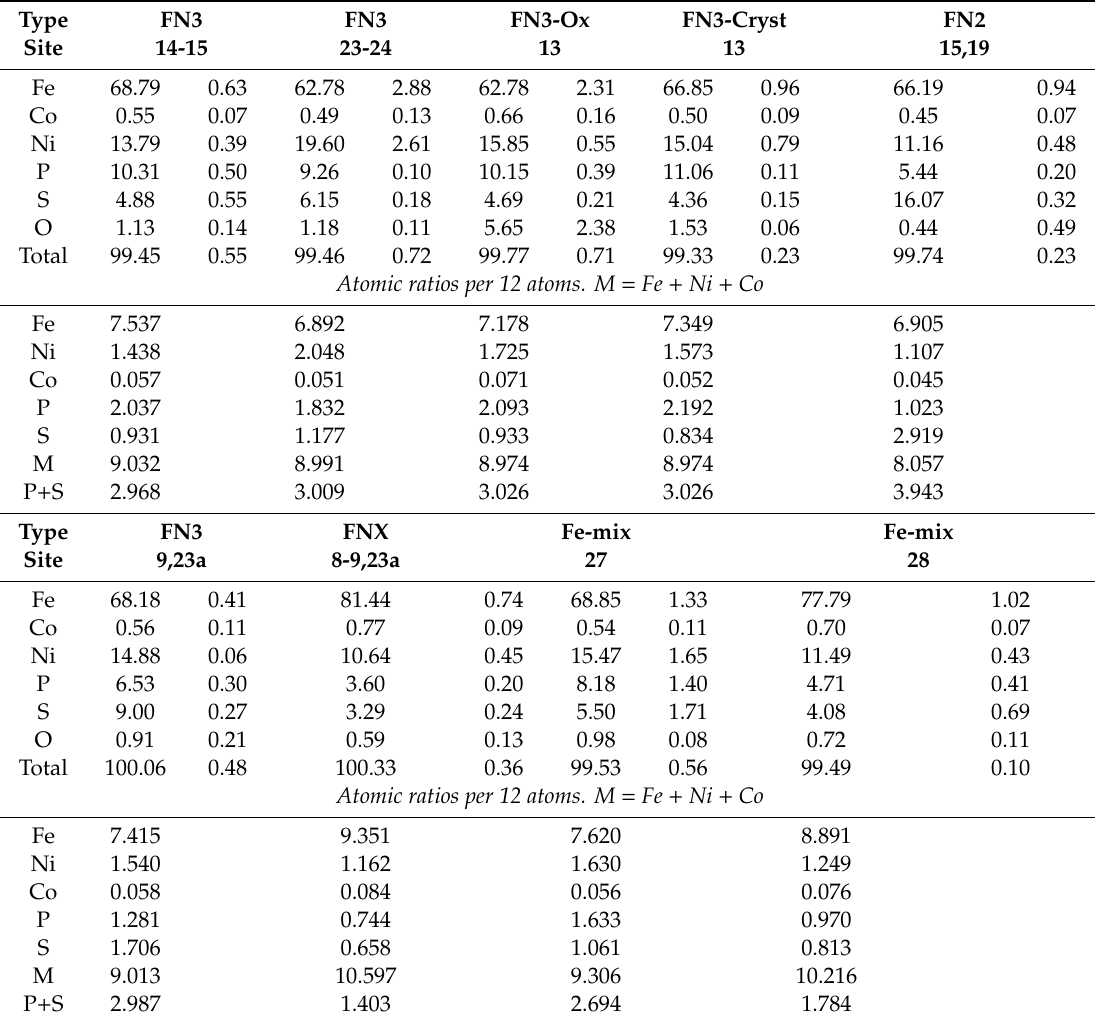
Table 2. Average compositions (wt %) of Fe–Ni–P–S melt pockets and crystalline aggregates from the Elga IIE iron